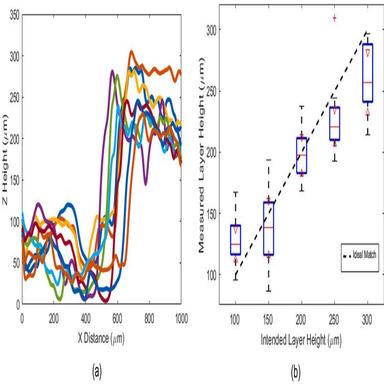
(a) Optical profilometry scans of a 5∘ wedge printed with a layer height of 200 μm, and (b) the combined measurements of layer heights ranging from 100 to 300 μm, printed with a speed of 4000 mm/min.